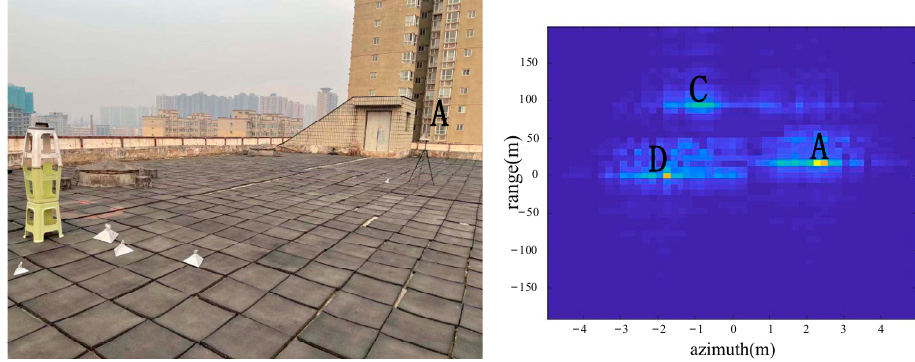
Figure 13. The 8th group of experimental scenes and imaging results. As shown in Figure 14, the corner reflector A was placed in the azimuth direction 9 m from the radar, and the corner reflector A was placed to the right of the center position in the azimuth direction. A was a big corner reflector, so the reflection of A was strong. The ordinate of A was negative because the distance between the corner reflector A and the radar was less than 17 m. As shown in Figure 15, two corner reflectors A and B were placed 17 m (left) and 9 m (right) from the radar, respectively. The two corner reflectors A and B were 2.5 m apart in the azimuth direction. The corner reflector A was on the left, 17 m in the distance, and the corner reflector B was on the right, 9 m in the distance. A and B were both big corner reflectors. According to the imaging results, the positions of A, B, C and D were consistent with the positions of objects in the actual scene.